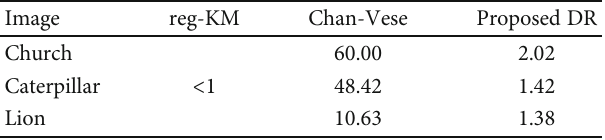
Figure 5: Segmentation results using reg-KM, Chan-Vese, and Douglas-Rachford (DR) algorithms.